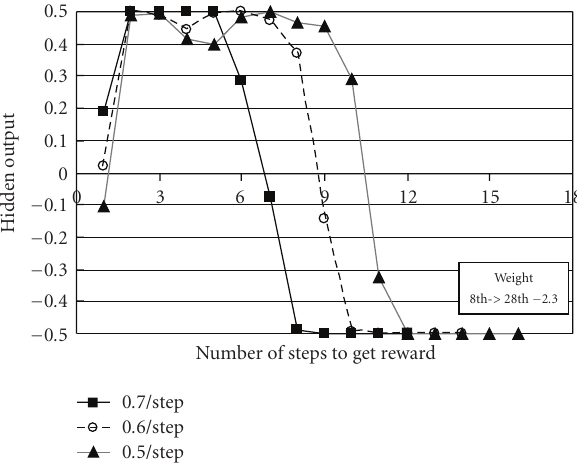
Figure 16: Output change of the 8th hidden neuron for the three